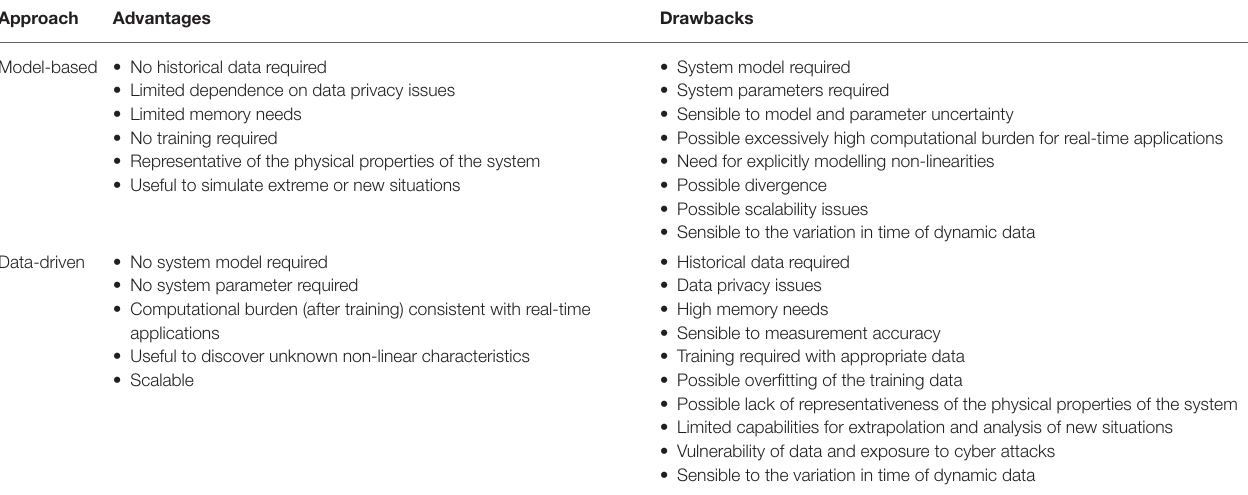
TABLE 1 | Advantages and drawbacks of the model-based and data-driven approaches. Approach